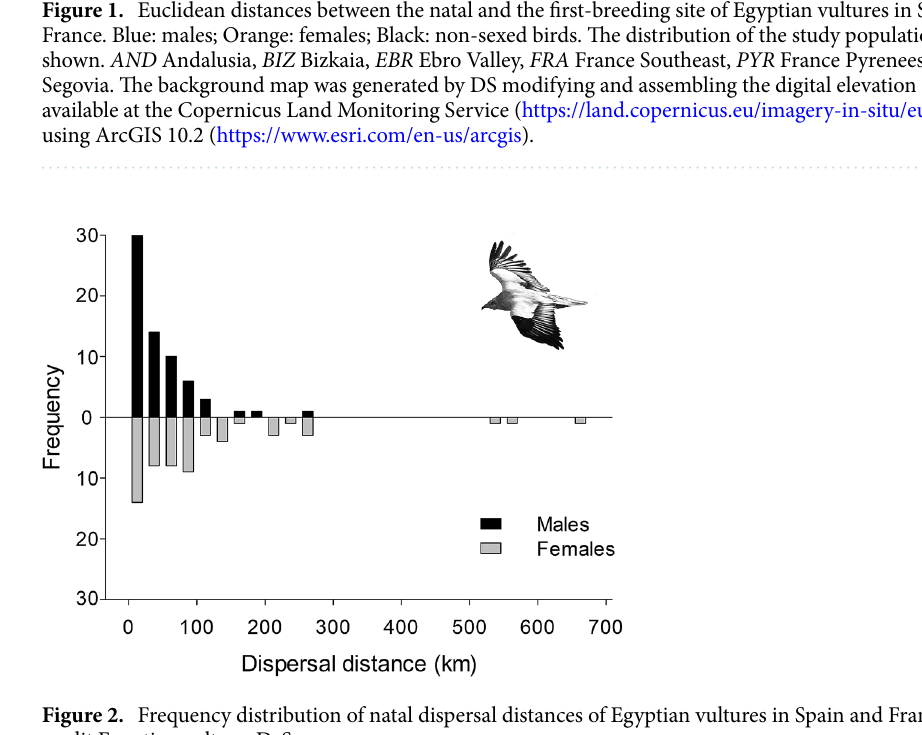
Figure 2. Frequency distribution of natal dispersal distances of Egyptian vultures in Spain and France. Photo credit Egyptian vulture: D.